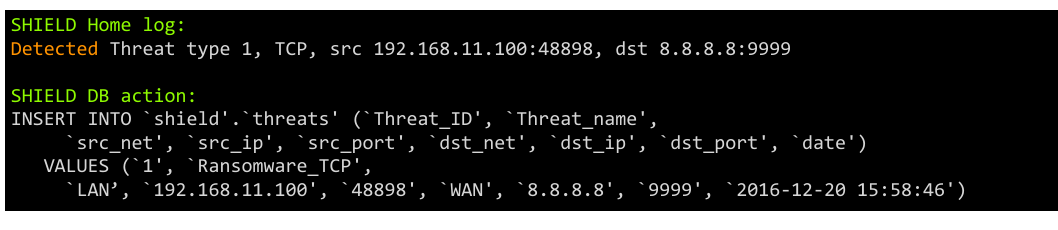
Figure 5. Detection of Ransomware attack on